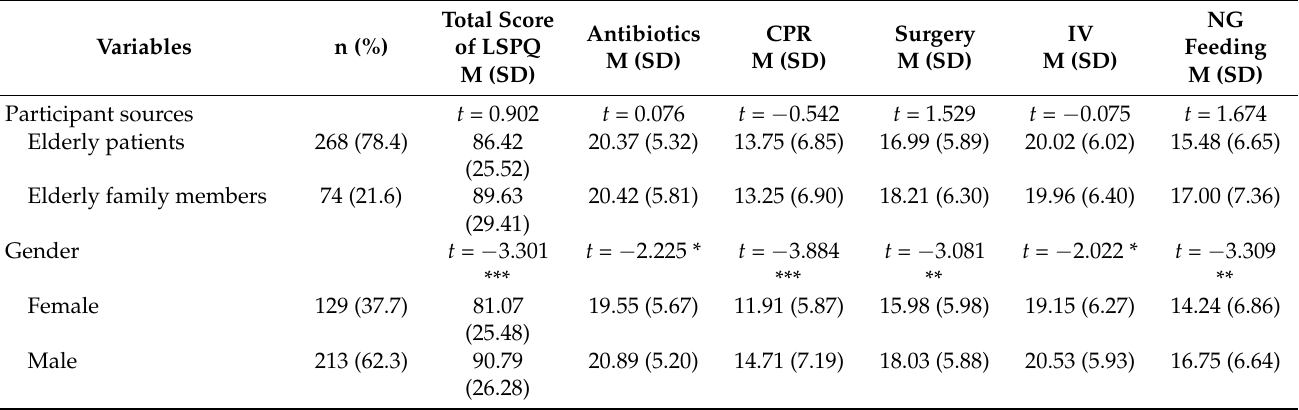
Table 1. Univariate analysis of the demographic characteristics of older adults and the LSPQ (N =